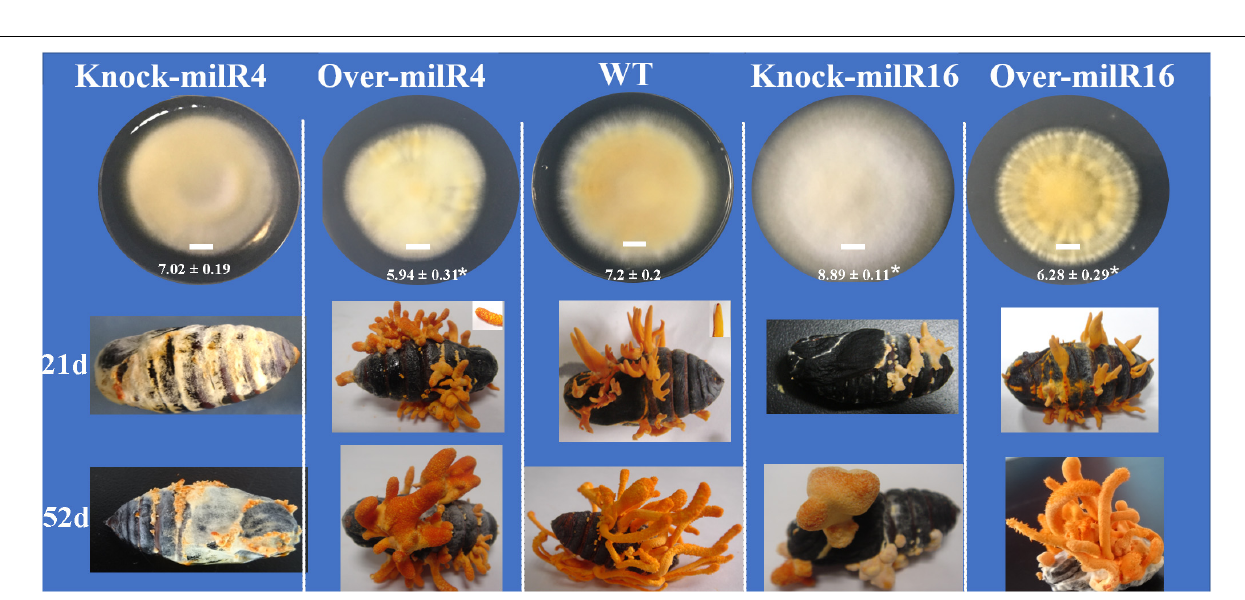
Frontiers in Microbiology |